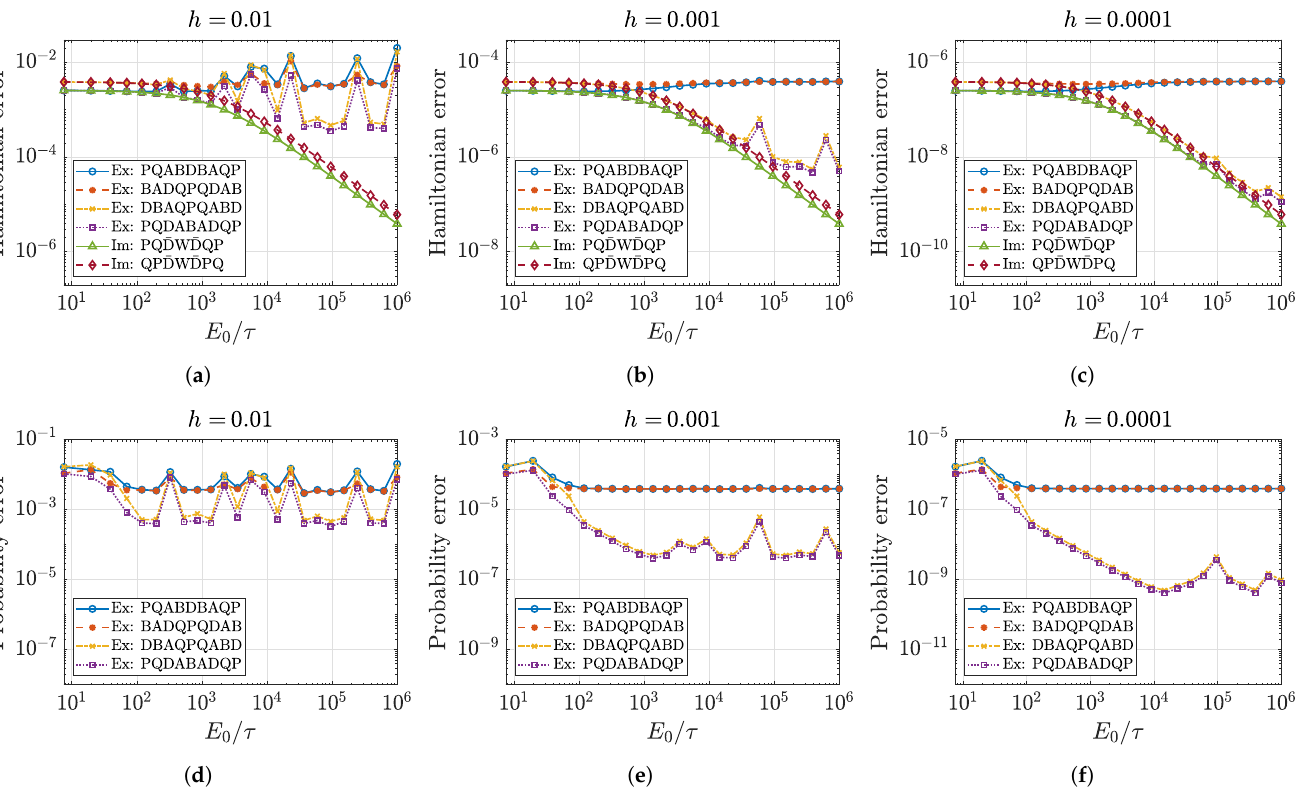
Figure 6. Hamiltonian and total probability conservation errors of the splitting methods: PQABDBAQP, BADQPQDAB, DBAQPQABD, PQDABADQP, PQ ¯DW ¯DQP, and QP ¯DW ¯DPQ. Top ( a – c ): maximal relative error of the Hamiltonian (42) for t ∈ [ 0,100 ] . Bottom ( d – f ): maximal relative error of the total charge probability (16) for t ∈ [ 0,100 ] , where results for semi-implicit methods are excluded. Left ( a , d ): time step h = 0.01. Middle ( b , e ): time step h = 0.001. Right ( c , f ): time step h = 0.0001. The Hamiltonian and probability errors are averaged over eleven numerical simulations with initial conditions (100) and (101) and different values of γ ∈ [ 0.4,0.9 ]